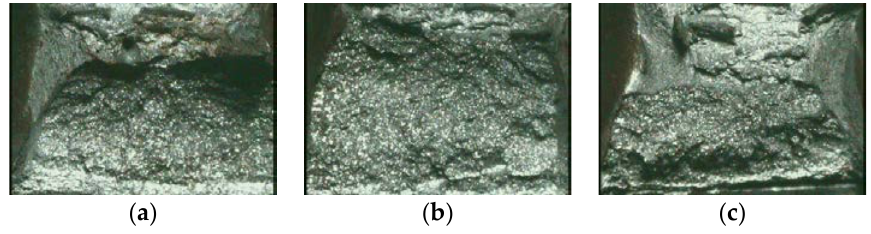
Figure 1. Macroscopic fracture ( − 20 °C): ( a ), impact fracture of 16 mm thickness plate; ( b ), impact fracture of 25 mm thickness plate; ( c ), impact fracture of 40 mm thickness plate.